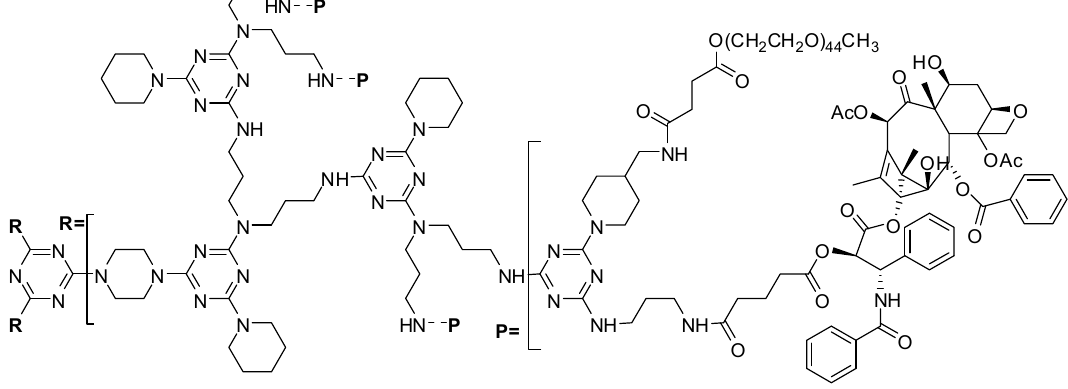
Figure 1. G3 Triazine dendrimer prodrug containing PEG and paclitaxel [27].